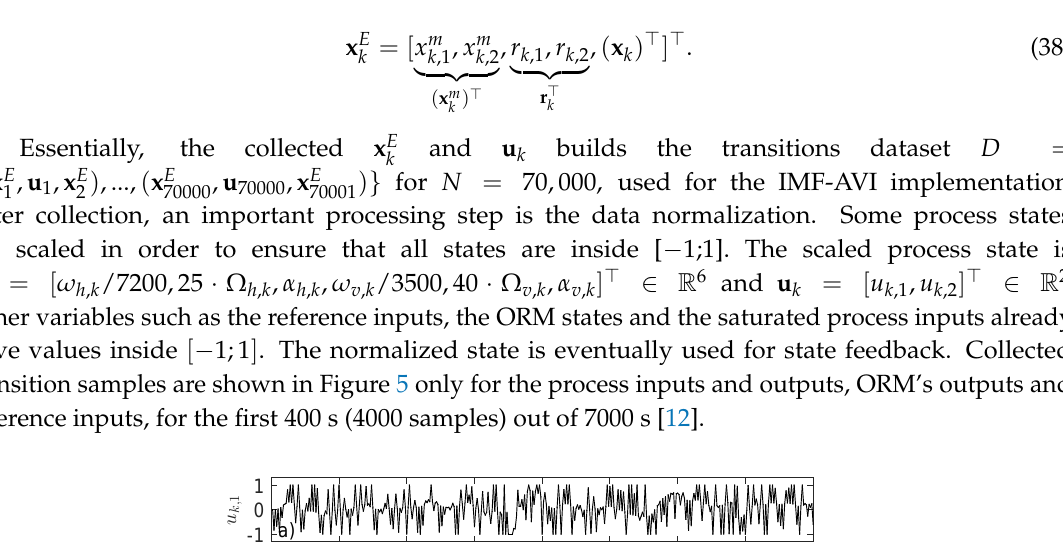
(red), r k ,1 (black k ,2